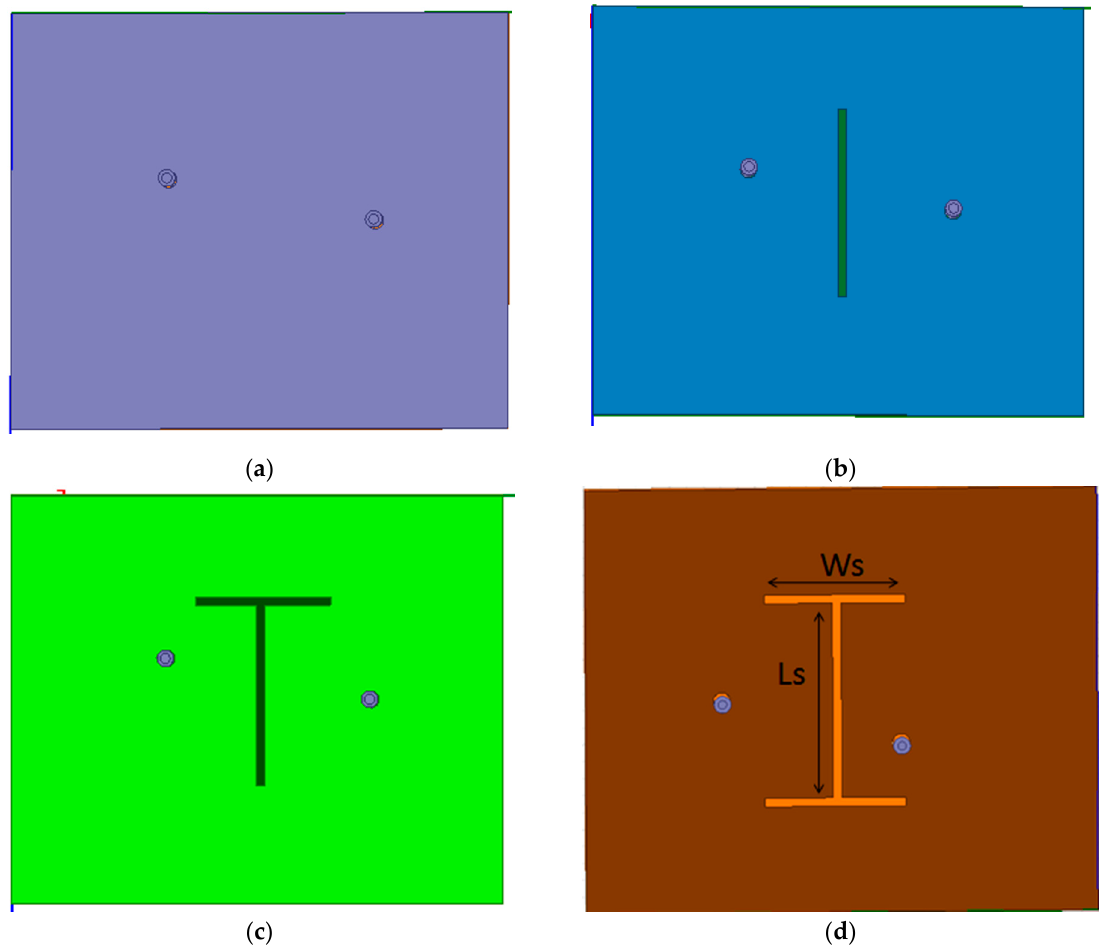
Figure 3. ( a – d ) The geometry of the given MIMO antenna with modification in the ground plane.